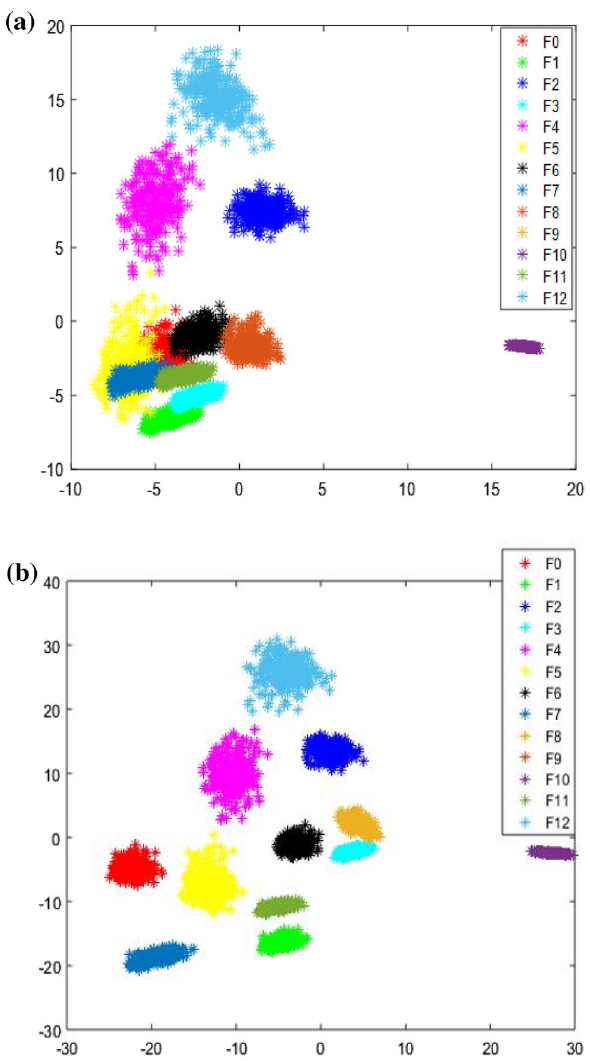
Figure 7. Characteristic distribution diagram of Case 2: ( a ) row data; ( b ) data after DBN feature extraction.